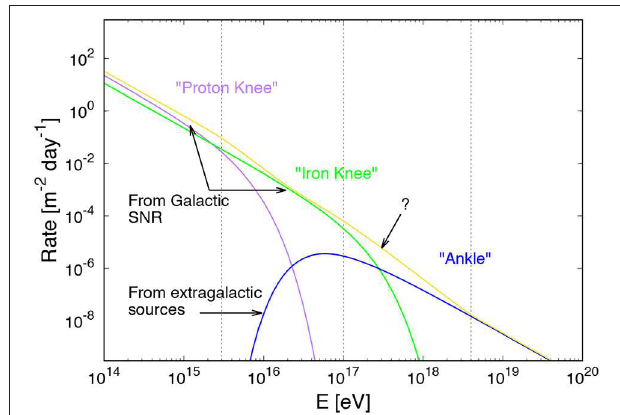
FIGURE 12 | Schematic illustration of the rate of cosmic rays incident on Earth as a function of energy, and the three distinct spectral breaks which can be seen in the cosmic-ray spectrum in this energy range, the proton knee, second knee, and ankle. A. Taylor for this